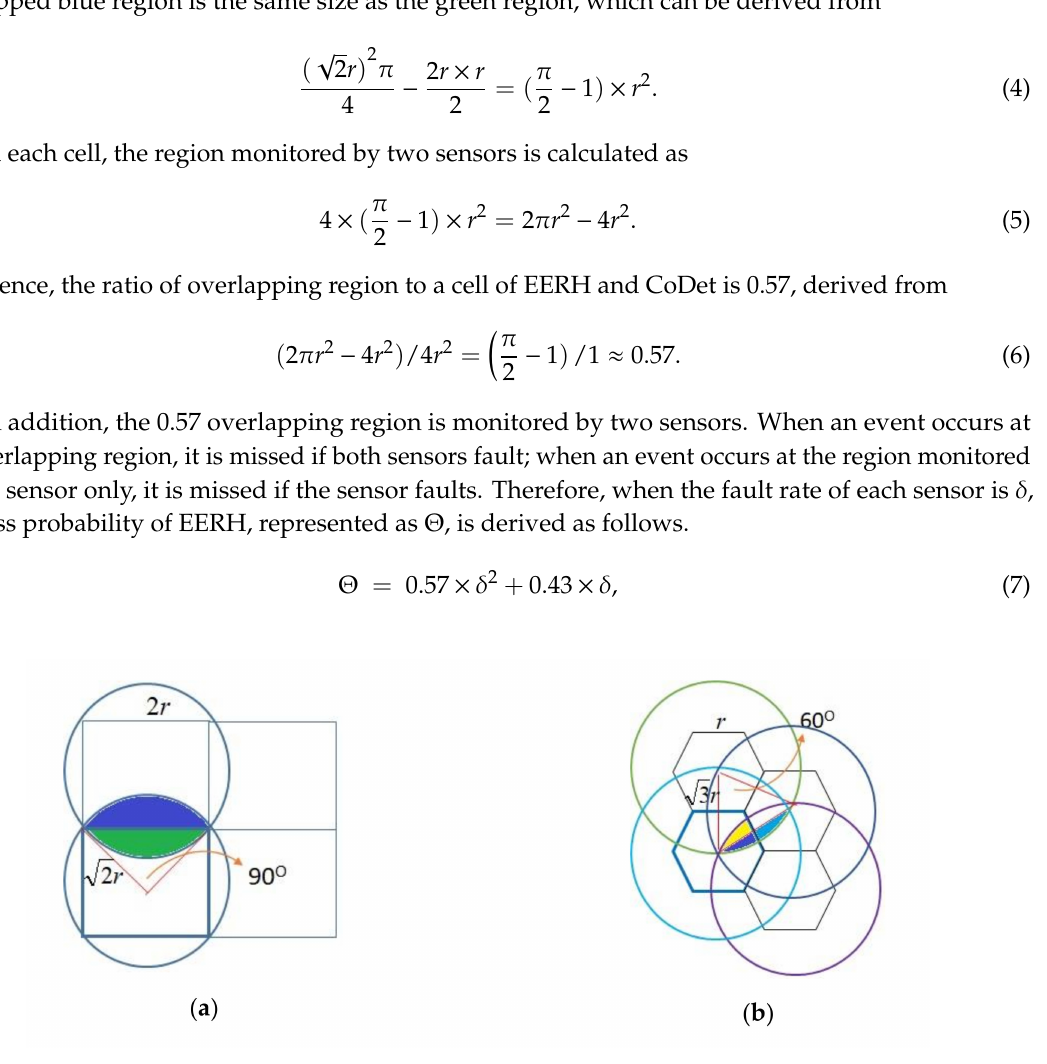
Figure 7. ( a ) An area monitored by two neighboring sensors in mechanisms EERH and CoDet; ( b ) an area monitored by four neighboring sensors in proposed mechanism,